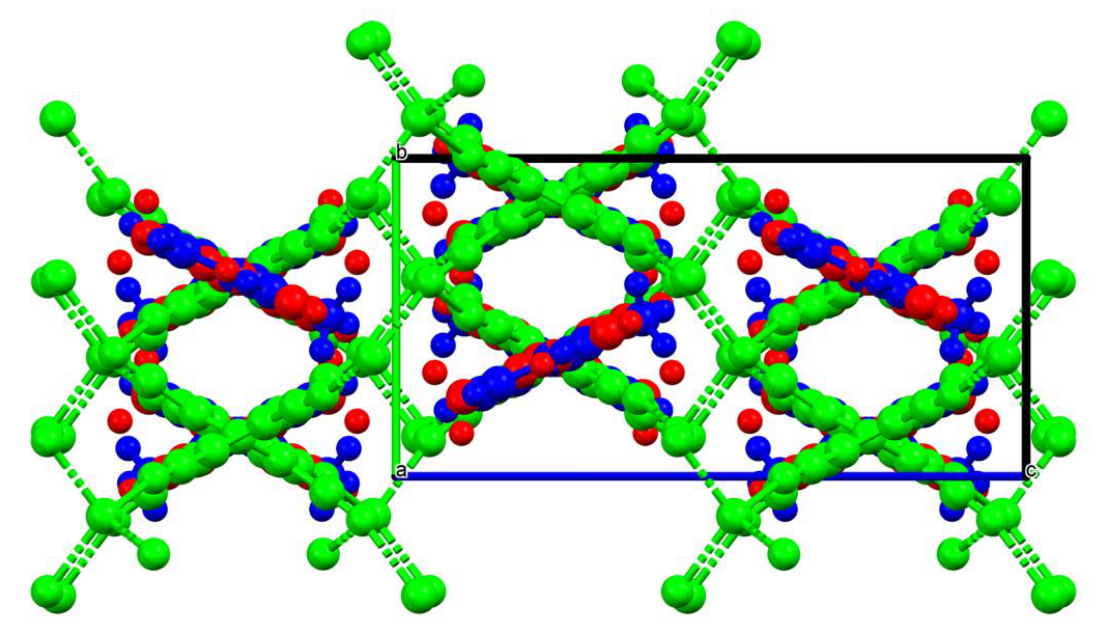
Figure 8. Packing plot ( MERCURY ) of compound 4 , watched along a . Same color coding as in Figure